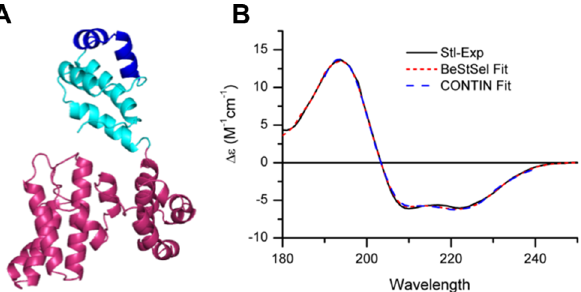
Fig 1. (A) Homology model of the Stl protein. Ribbon representation of the homology model of the Staphylococcus aureus pathogenicity island repressor Stl produced by Phyre2 Server [38]. Based on the homology model the protein is highly α helical (74%), and seems to be divided into two segments: the amino terminal segment colored cyan and the carboxy-terminal segment colored hotpink. According to Pfam and NCBI CDD the protein is predicted to contain a helix-turn-helix DNA binding motif. The position of the HTH predicted by NPS@ server is colored to dark blue [44]. (B) SRCD spectrum of Stl and fitted curves by BeStSel and CONTIN algorithms. Stl was measured at 2.1 mg/ml concentration in 50 mM Hepes, 200 mM NaCl, pH